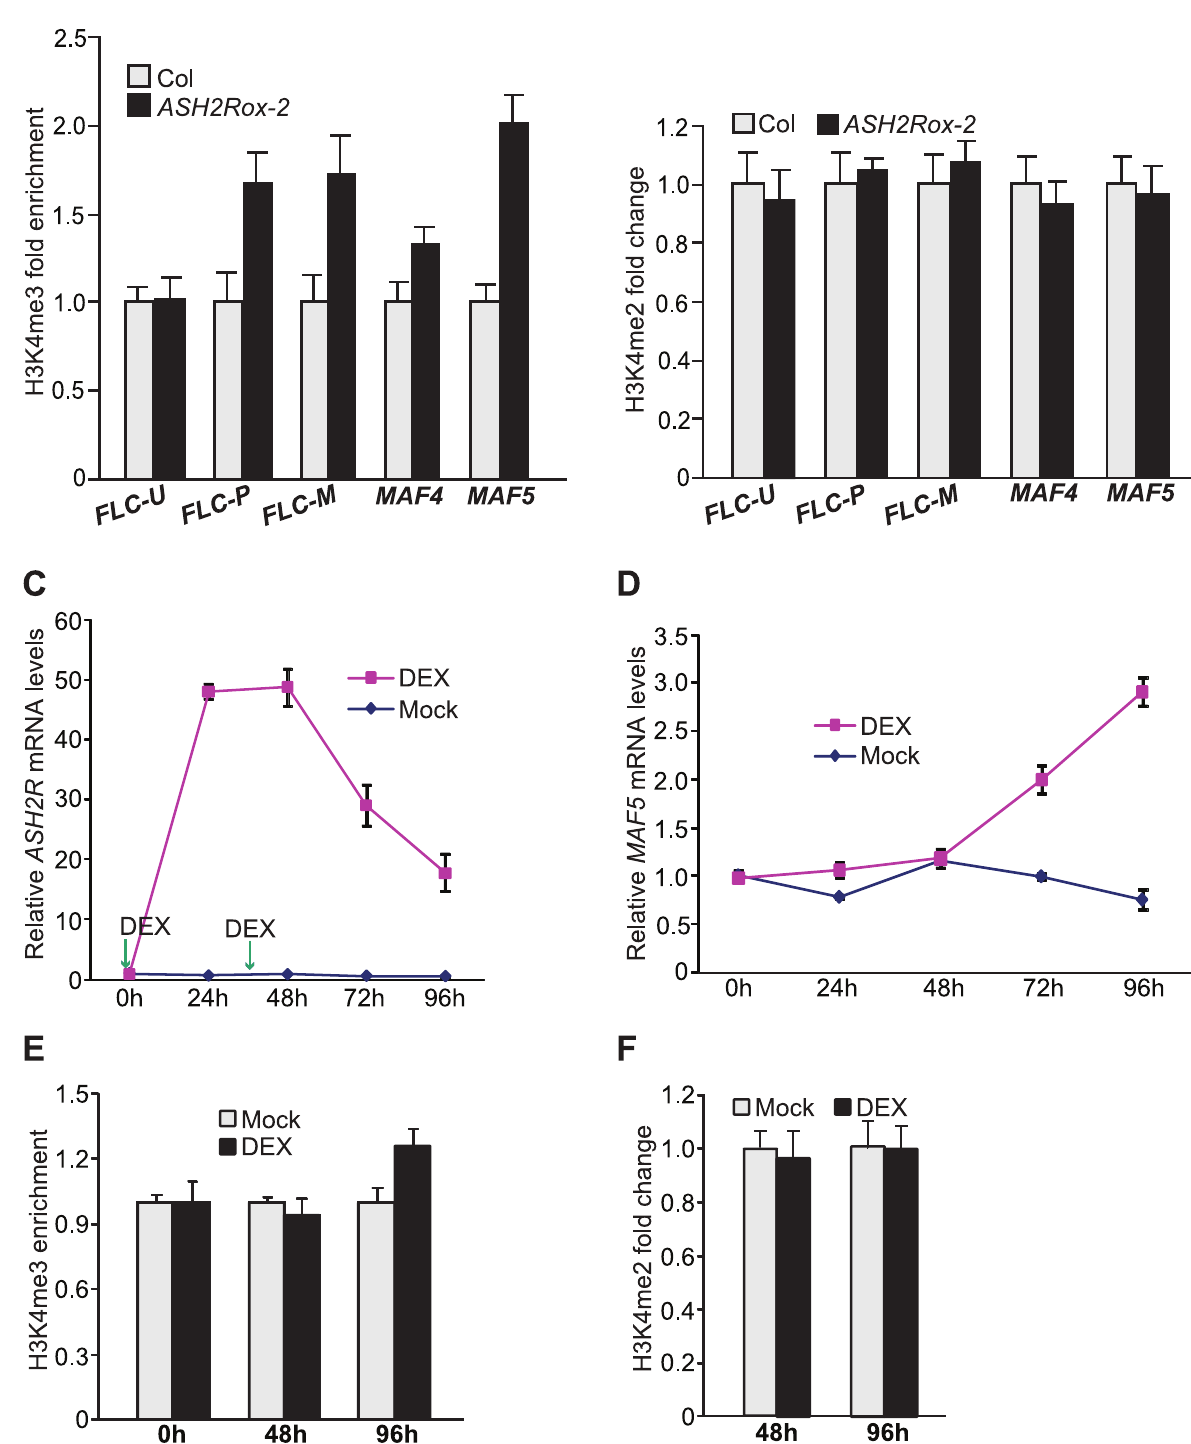
Figure 11. Gain of ASH2R Function Leads to Increased H3K4 Trimethylation in Its Direct Target Genes. (A) Analysis of H3K4me3 in FLC , MAF4 and MAF5 in Col and ASH2Rox-2 seedlings. The amounts of genomic fragments immunoprecipitated with anti-H3K4me3 were quantified and subsequently normalized to TUB2 . Relative fold changes of ASH2Rox-2 over Col at the indicated regions (as illustrated in Figure 10A) are shown. Error bars indicate SD. (B) Relative levels of H3K4me2 in FLC , MAF4 and MAF5 chromatin in Col and ASH2Rox-2 seedlings. (C) ASH2R expression in the pOp6- ASH2R ; p35S-GR:LhG4 line (in the Col background) upon DEX treatments. Seedlings were treated with 10 m M DEX twice (at 0h and 36h as indicated by the arrows), and shoot apices with newly emerged leaves were harvested 0, 24, 48, 72 and 96 h after the initial treatment. DEX was omitted in the mock control. ASH2R transcript levels were quantified by real-time quantitative RT-PCR. Relative expression to 0h is presented; bars indicate SD. Note